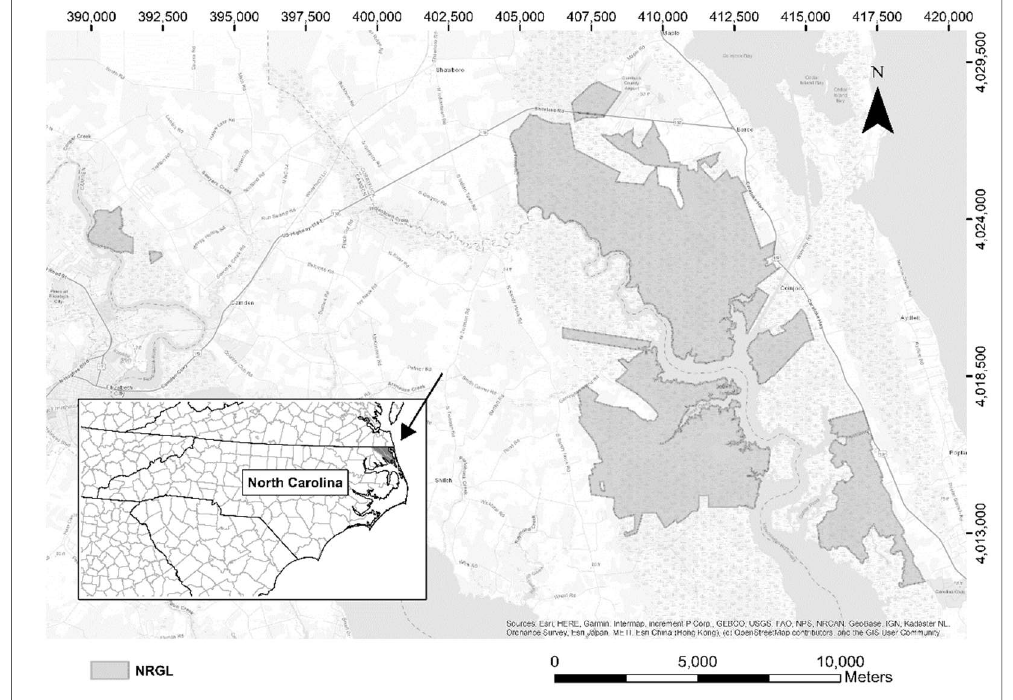
Figure 1. Location of North River Game Land (NRGL) in Camden and Currituck counties, North Carolina, 2019.